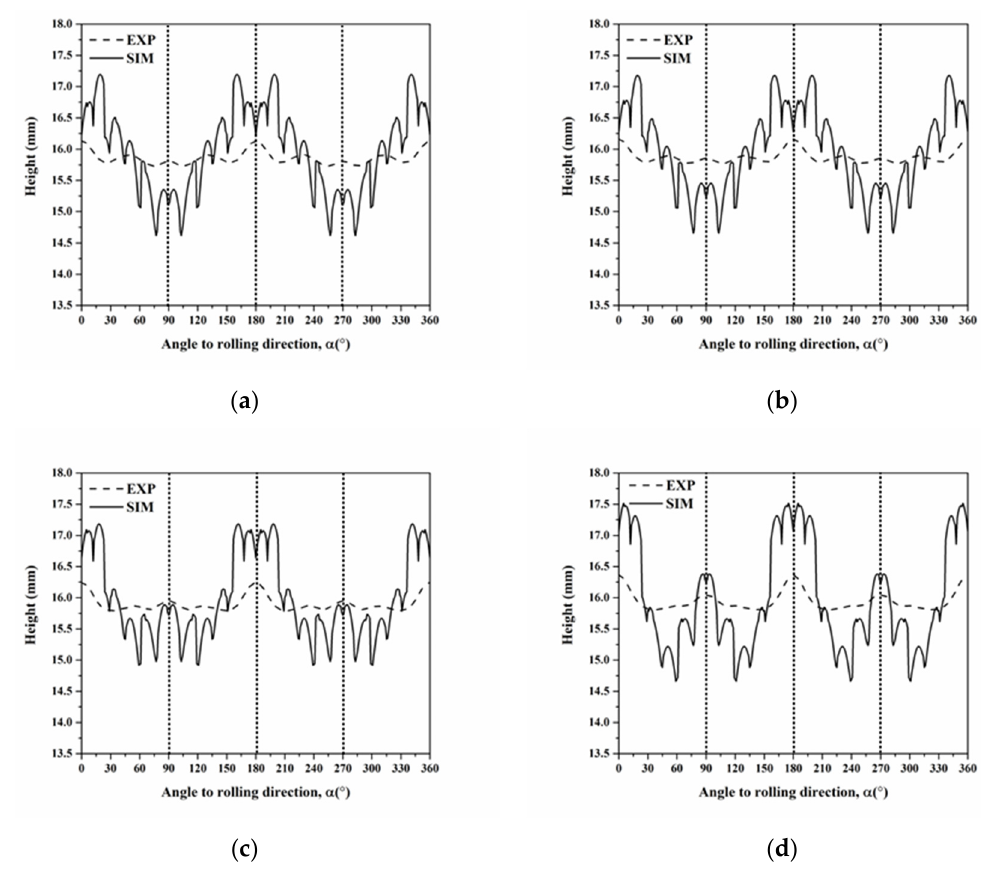
Figure 13. Cup height profiles as a function of the angle in AA5151 alloy at 250 °C for ( a ) 0.5, ( b ) 1, ( c ) 2, and ( d ) 3 h using six components considering the single slip system without orientation spread (Dashed and continuous lines mean experiment and simulation, respectively).